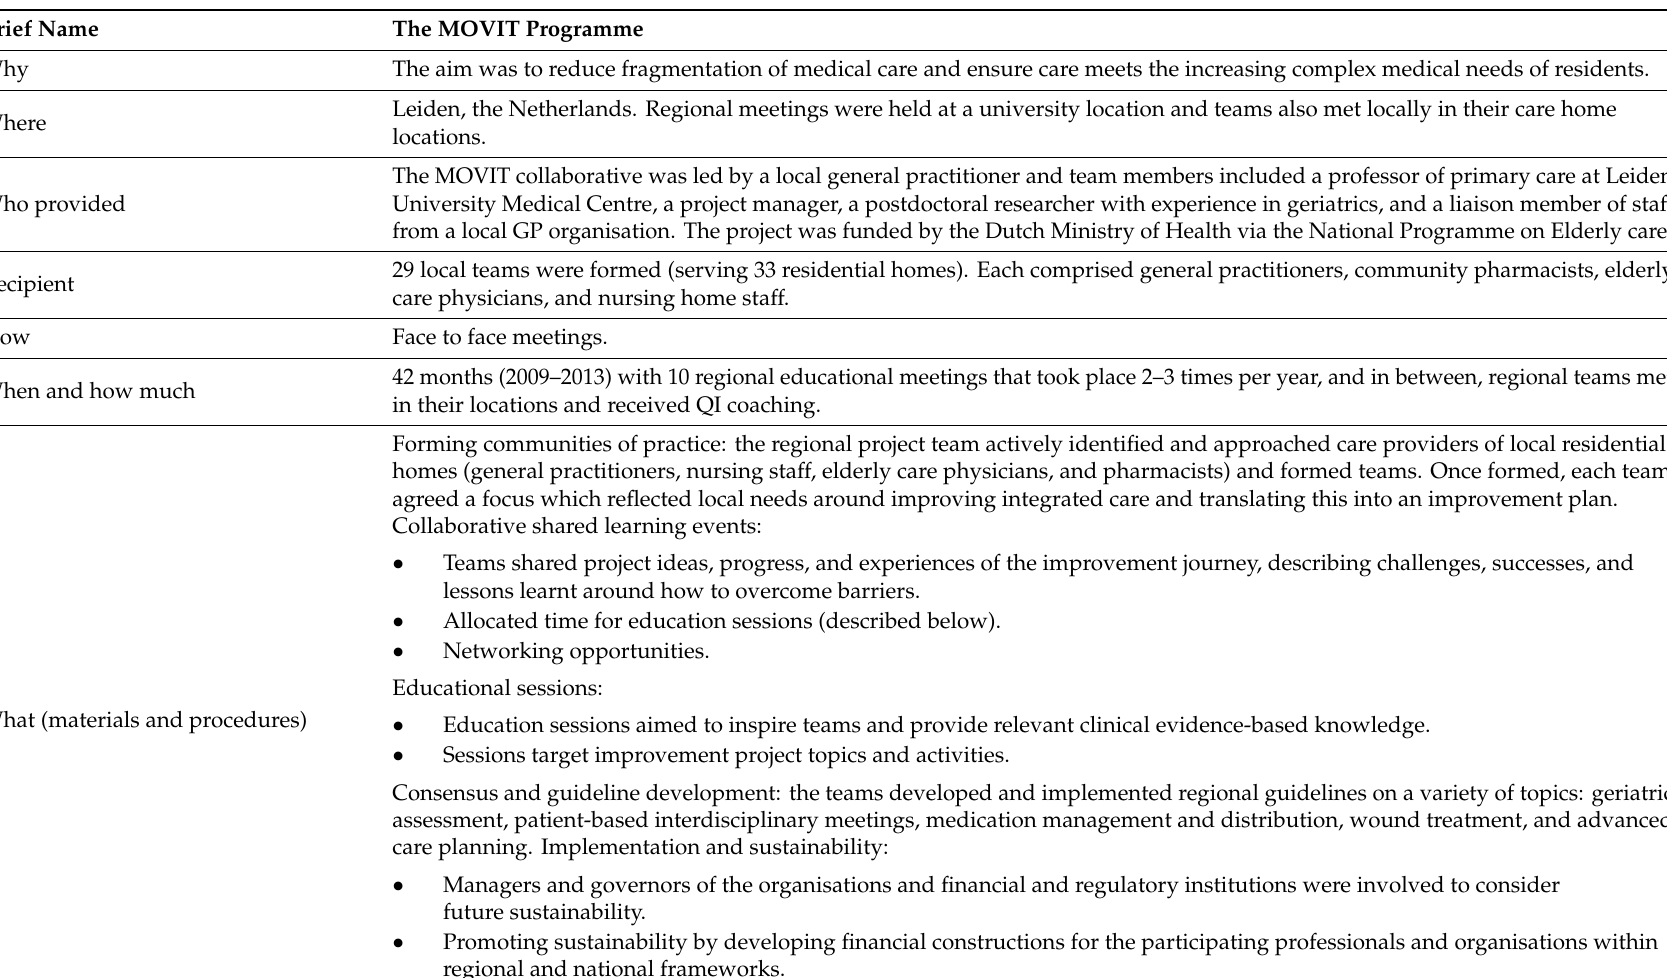
Table 5. Description of the MOVIT Quality Improvement